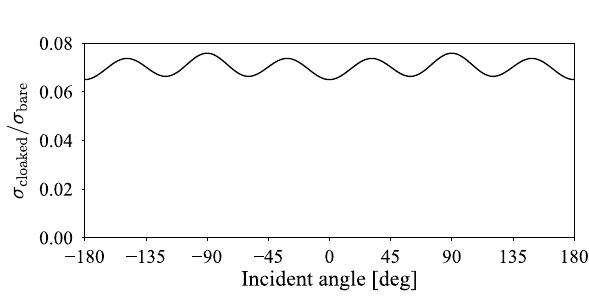
Figure 2. Scattering cross section of the designed cloak at various incident angles.